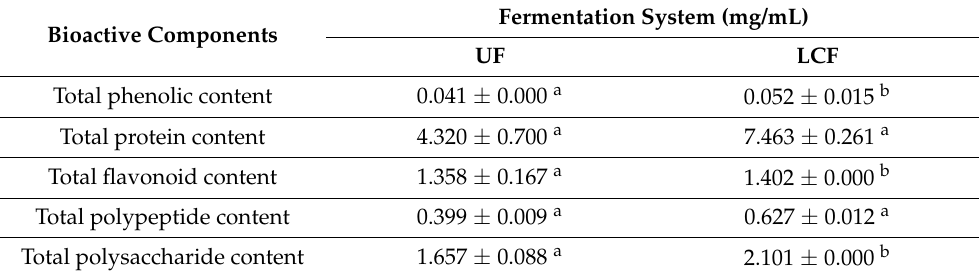
Table 1. Major Euryale ferox bioactive component variations across various fermentation processes.